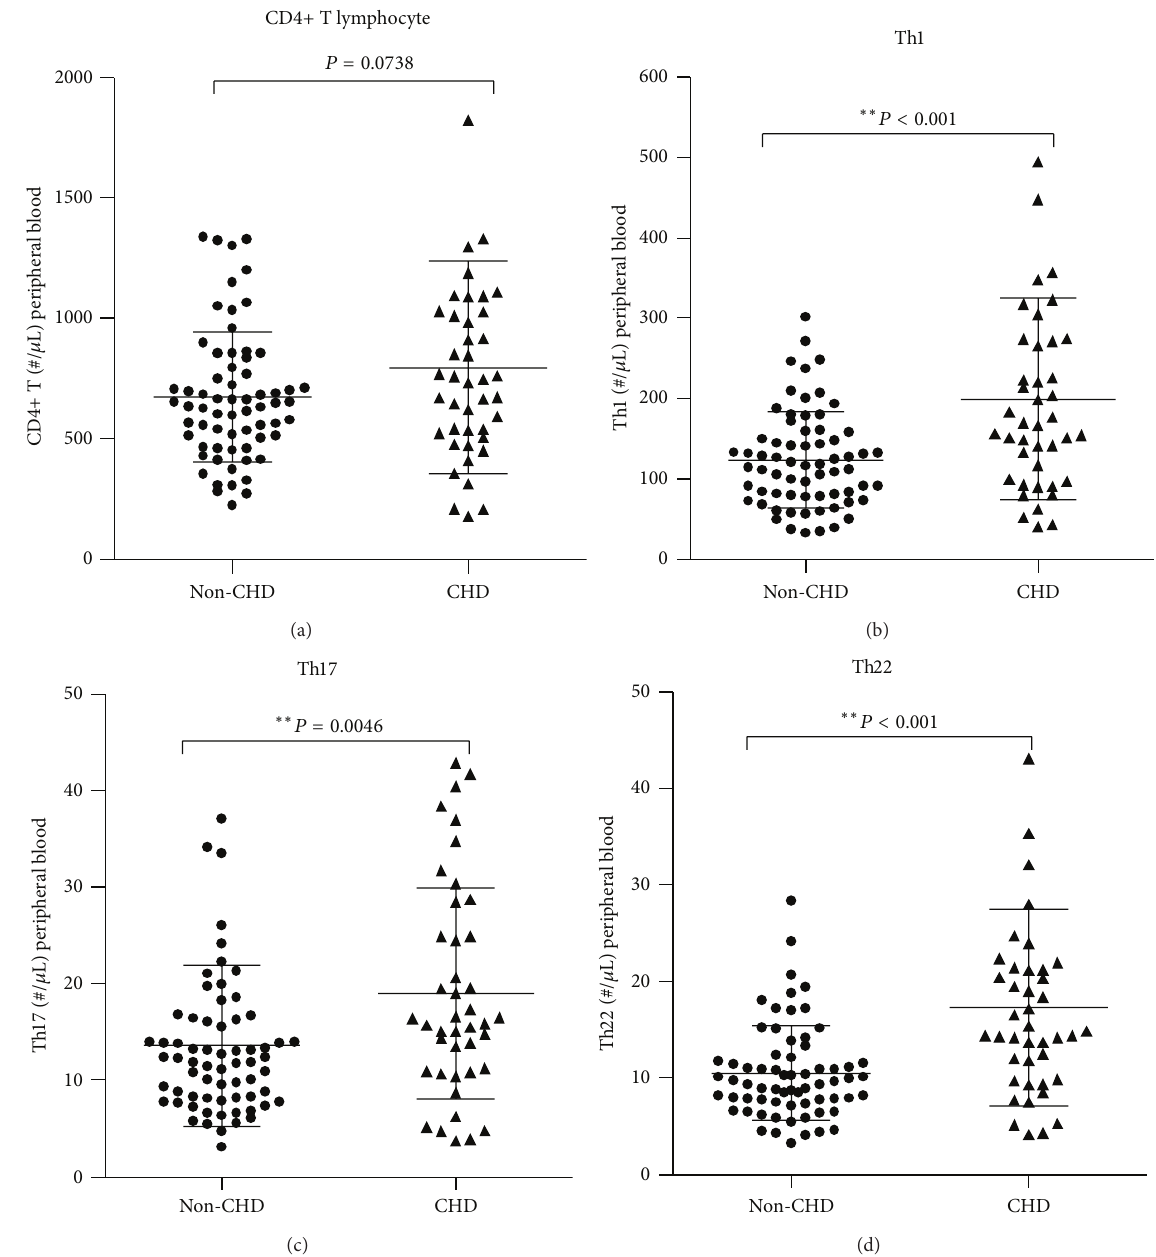
Figure 2: Absolute numbers of Th22, Th1, and Th17 cells were significantly higher in diabetic patients with CHD than those without CHD. AbsolutenumbersofTh22,Th1,andTh17cellsaswellastotalCD4+Tcells.(a)Elevatingtendencywasobservedbutnotstatisticallysignificant in absolute numbers of CD4+ T cells in CHD group ( 𝑃 = 0.0738 ). (b) Significant increases in Th1 numbers were observed in CHD group ( 199.9 ± 125.40 ) compared to non-CHD group ( 123.5 ± 59.90 ) ( ∗ 𝑃 < 0.0001 ). (c) Significantly elevated percentages of Th17 cells were also found in CHD group ( 19.01 ± 8.35 versus 13.64 ± 10.94 ) ( ∗ 𝑃 = 0.0046 ). (d) Elevations in Th22 cells were more remarkable in CHD group ( 17.32 ± 10.20 versus 10.53 ± 4.855 ) ( ∗ 𝑃 < 0.0001 ). Bars represent